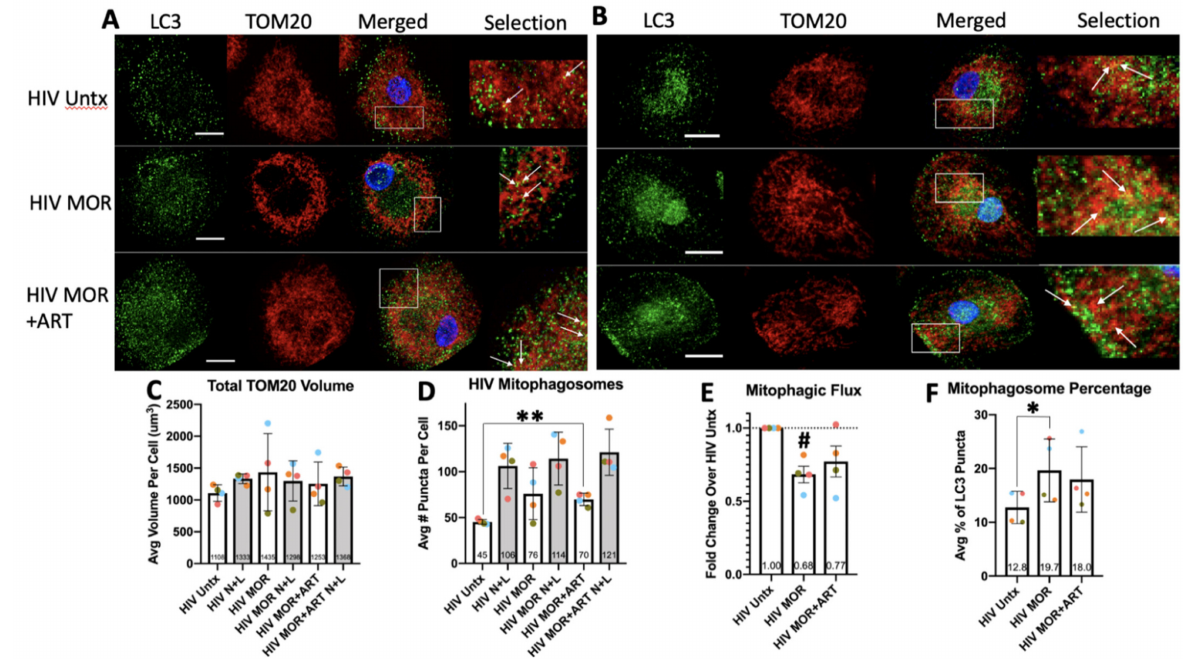
Figure 6. Analysis of mitophagy in HIV-infected MDM in response to morphine with/without ART by immunofluorescence. HIV-infected macrophages were cultured on coverslips and stained for LC3 (green), representing autophagosomes, and TOM20 (red), a mitochondrial protein representing mitochondrial mass. Coverslips were imaged in Z-series by confo- cal microscopy. ( A ) Representative images of infected MDM that were untreated (HIV Untx) or treated with morphine with/without ART. Arrows point to mitophagosomes, which are LC3 puncta positive for mitochondria. ( B ) Represen- tative images of infected MDM treated or not and incubated with N+L in the last 4 h of treatment. Arrows point to mitophagosomes, LC3 puncta positive for mitochondria. ( C ) Total volume of TOM20 staining per cell was quantified per treatment. ( D ) Average number of mitophagosomes per cell was quantified per treatment. ( E ) Using the average number